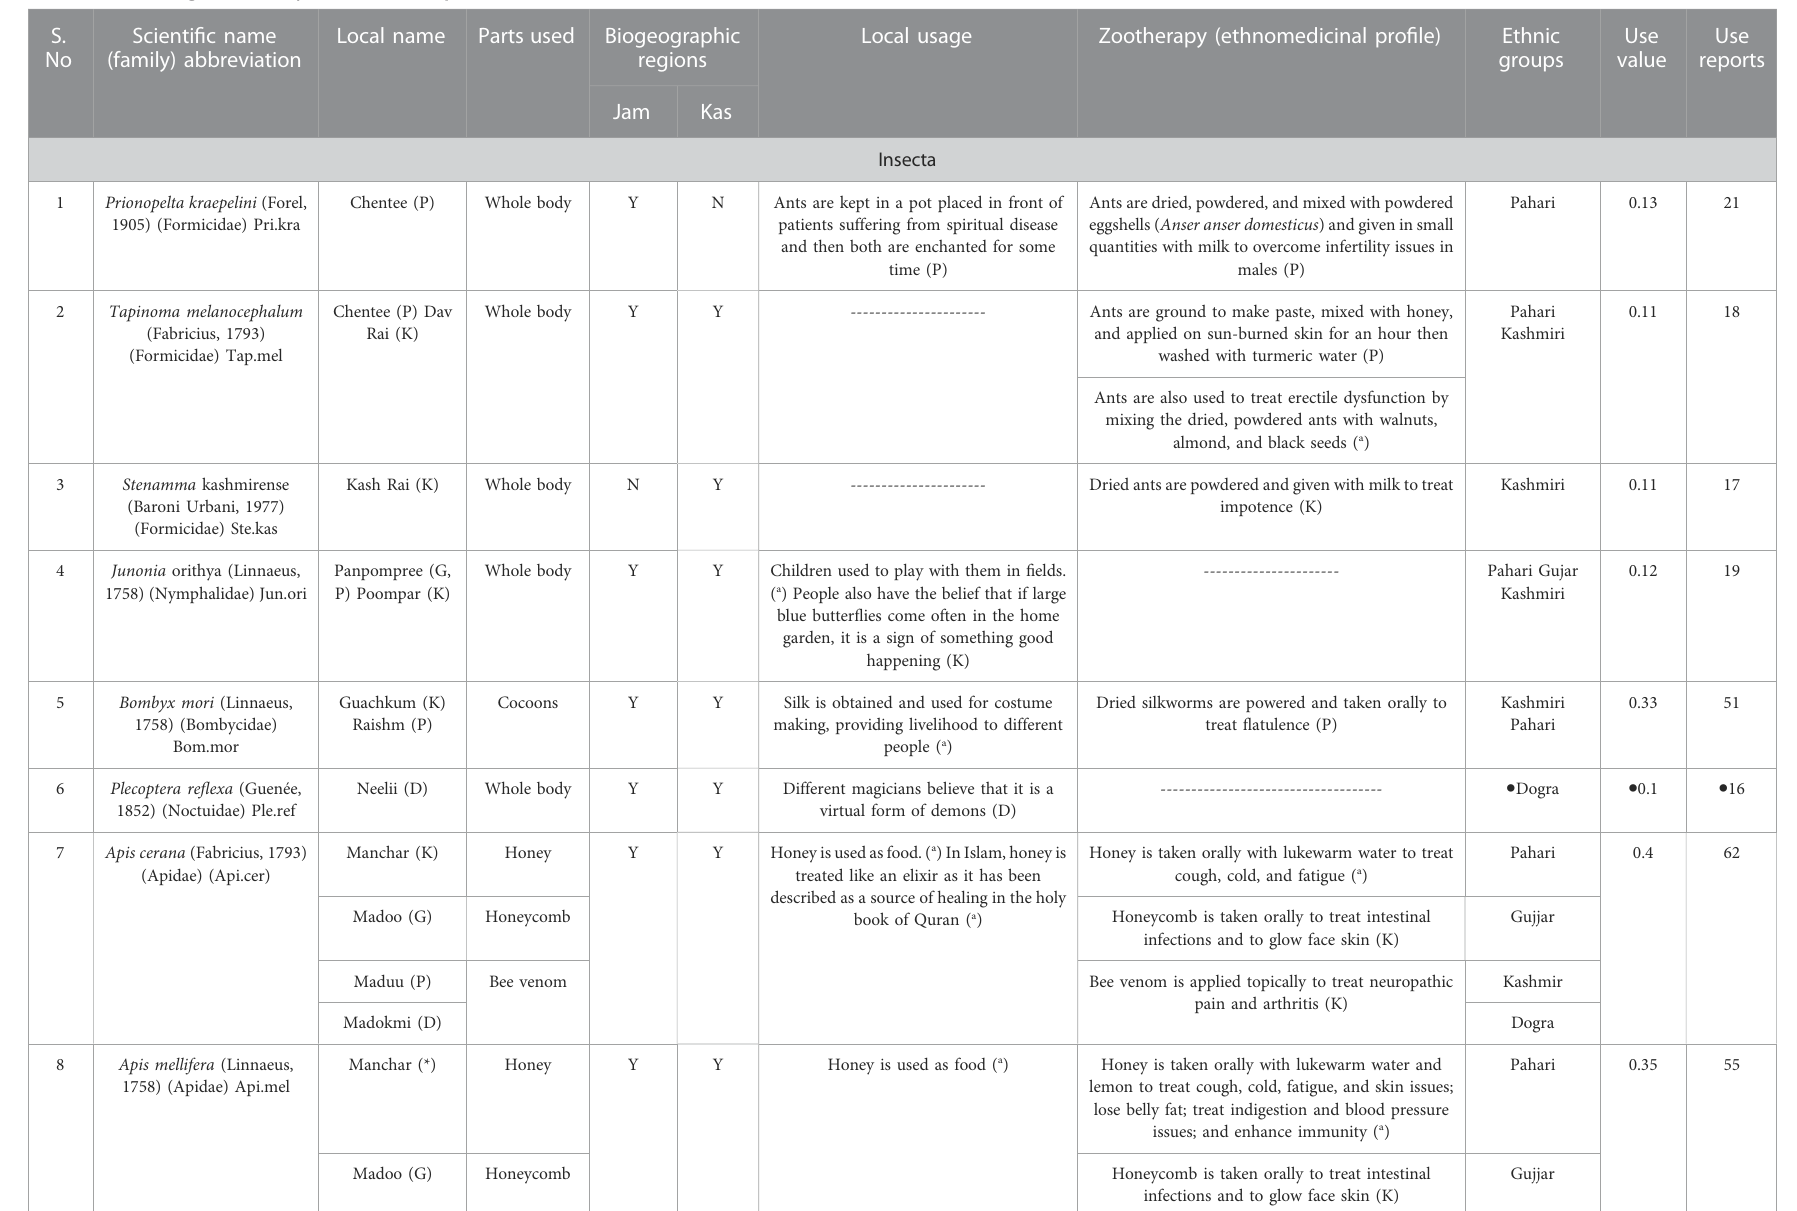
TABLE 2 Ethnozoological inventory of documented species from Jammu and